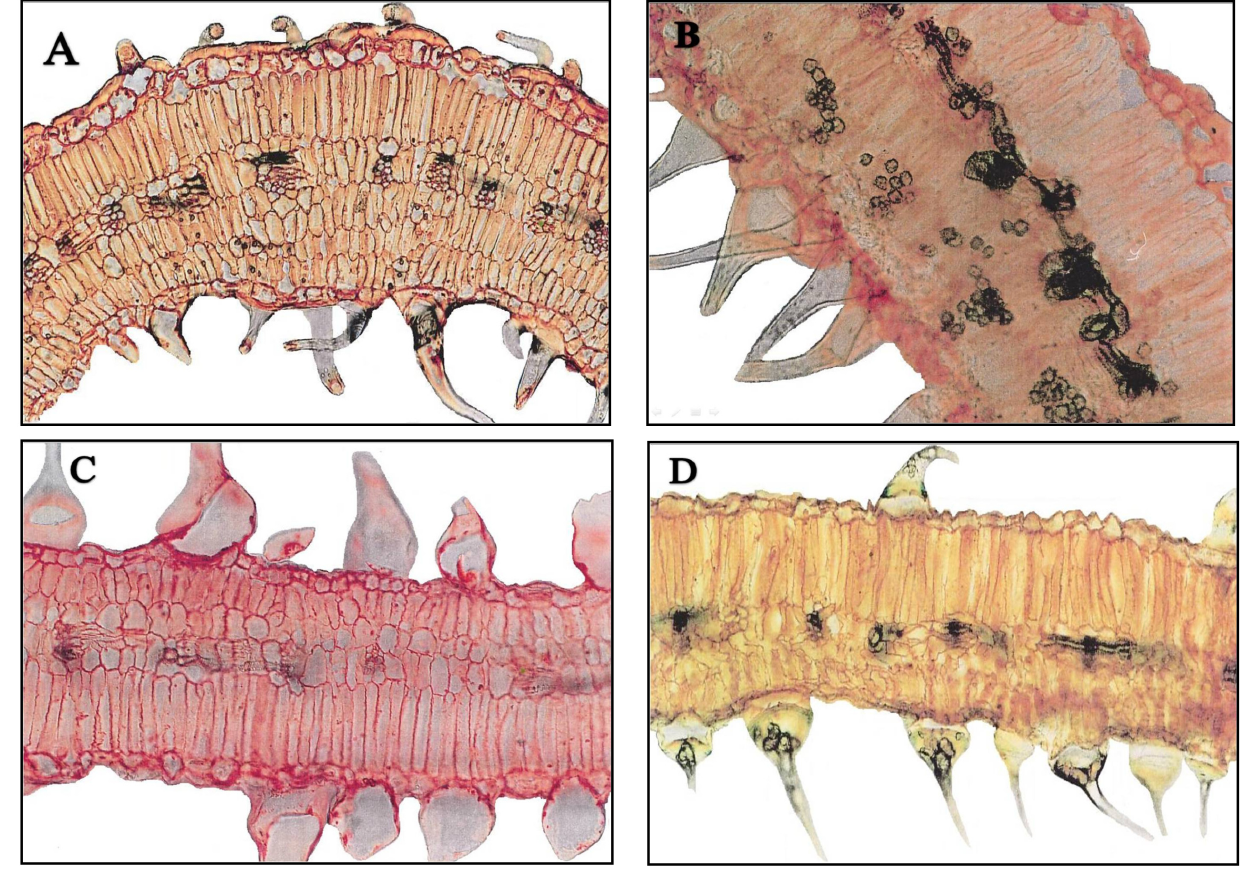
Fig. 6. Lamina of Heliotropium species in T.S; H. aucheri (A); H. carmanicum (B); H. lasiocarpum (C); H. suaveolens (D)